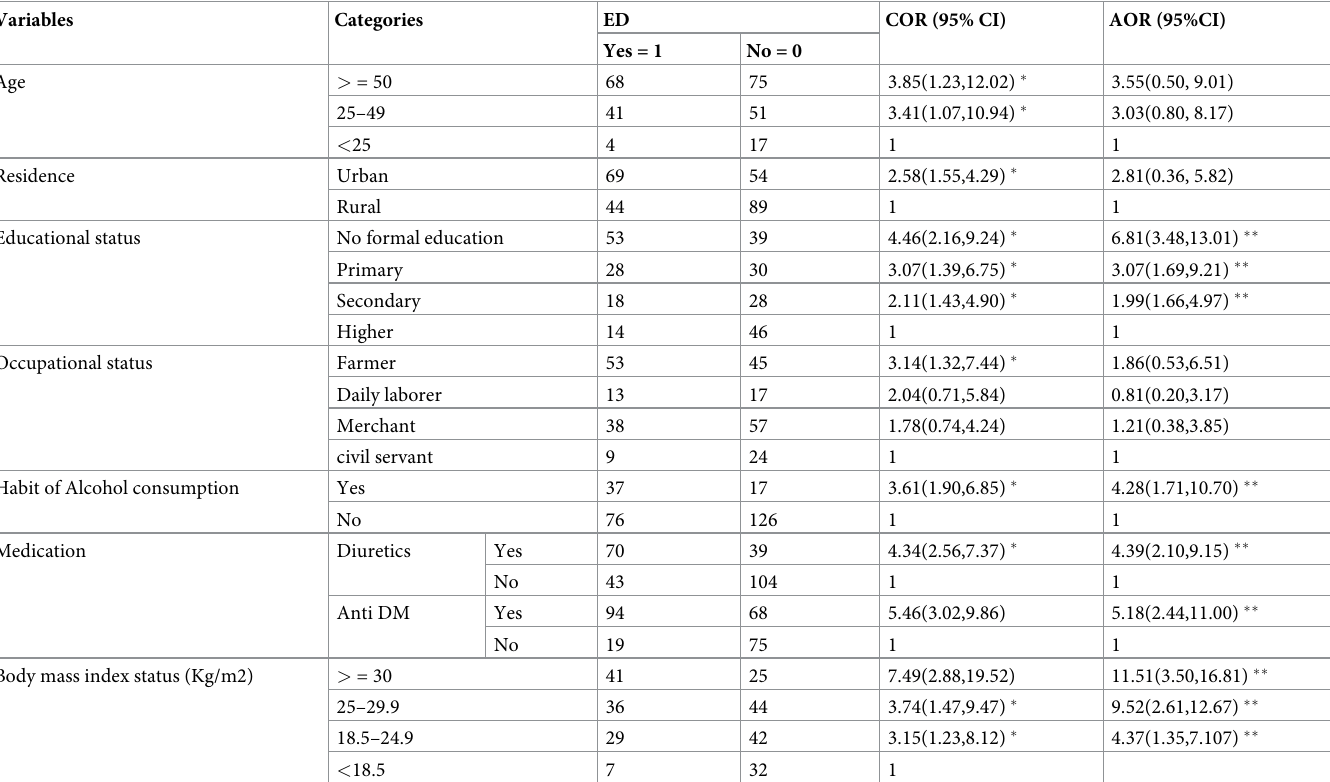
Table 4. Bivariate and multivariable logistic regression analysis of factors associated with electrolyte disturbances among patients admitted to medical ward with metabolic syndromes, in Jimma Medical Center, South west Ethiopia from April-May